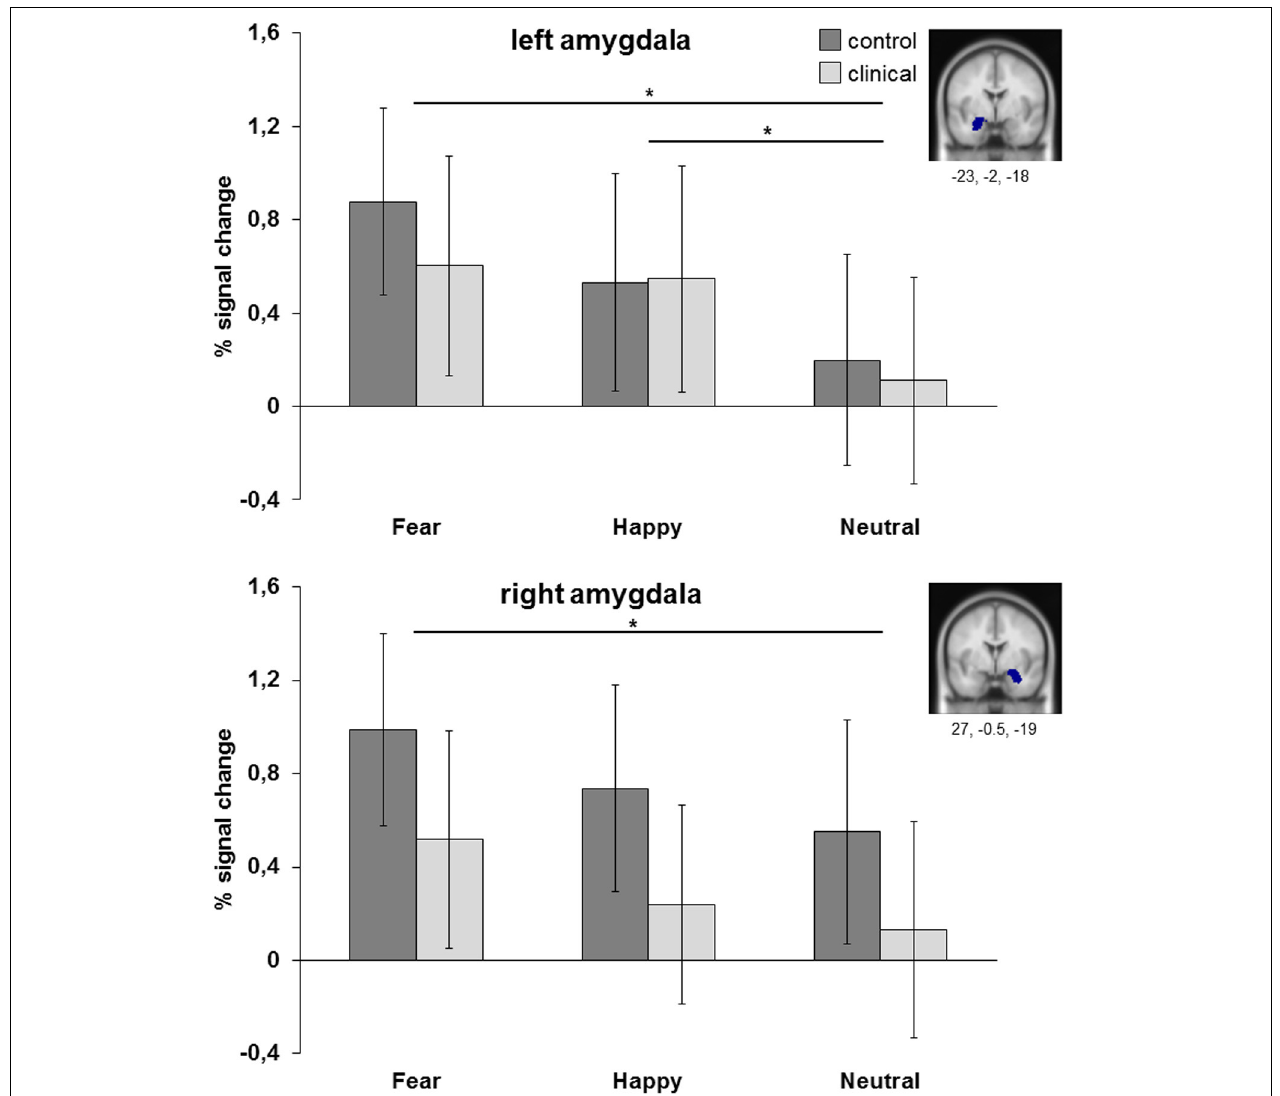
FIGURE 4 | ROI analyses of left and right amygdala (anatomical). Results are collapsed across attention conditions. ∗ p < 0 .